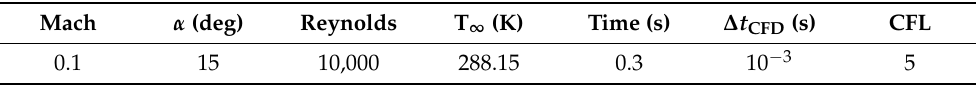
Table 1. NACA0009 simulation